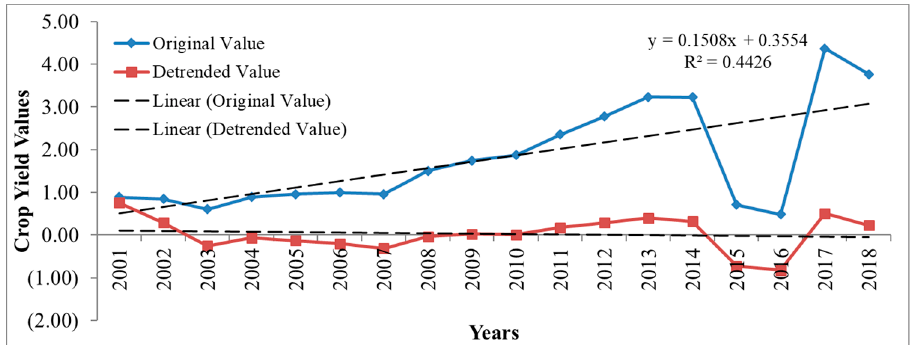
Figure 11. Original and detrended crop yield pattern of Maize crop.